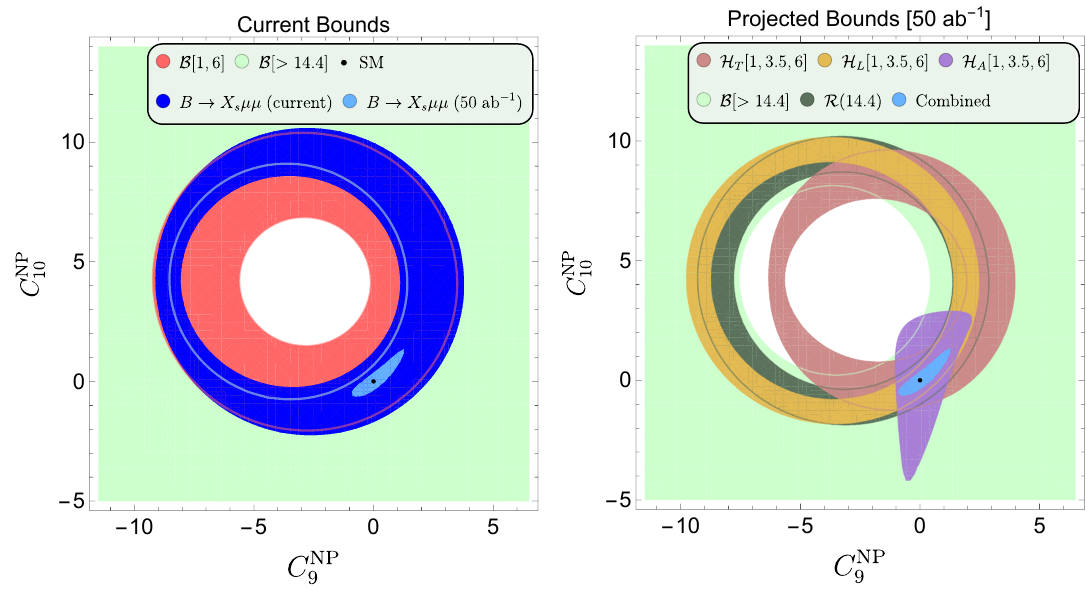
Figure 2 . Current (left panel) and expected bounds (right panel) on the new physics contributions to the Wilson coe(cid:14)cients C 9 ( (cid:22) 0 ) and C 10 ( (cid:22) 0 ) with (cid:22) 0 = 120 GeV. The coe(cid:14)cients C 7 ; 8 are kept at their SM values. All regions are determined at 95% C.L.. In both panels we combine the electron and muon channels under the assumption C e = C (cid:22) . In the 50 ab (cid:0) 1 extrapolation we combine 9 ; 10 9 ; 10 separately projected measurements of H T , H L and H A in the two low- q 2 bins.